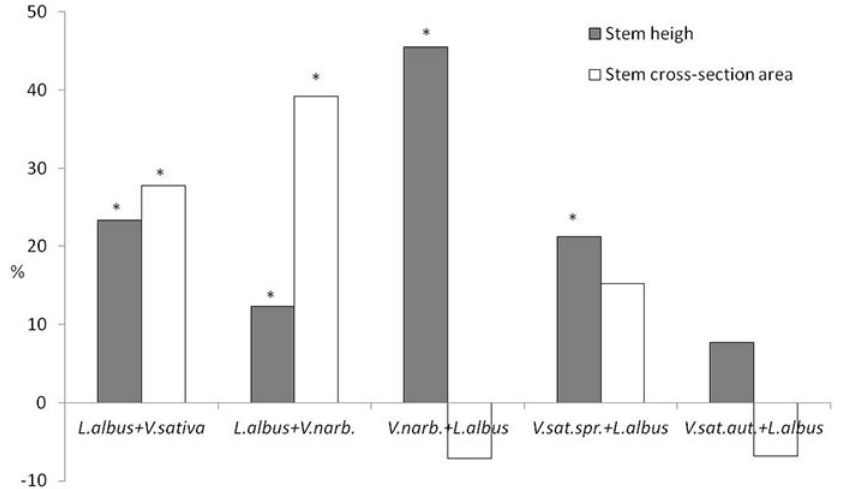
Fig. 2. The effect of intercropping on stem morphological parameters of legume forages, expressed as a percentage of the values obtained for the control plants, grown as a pure